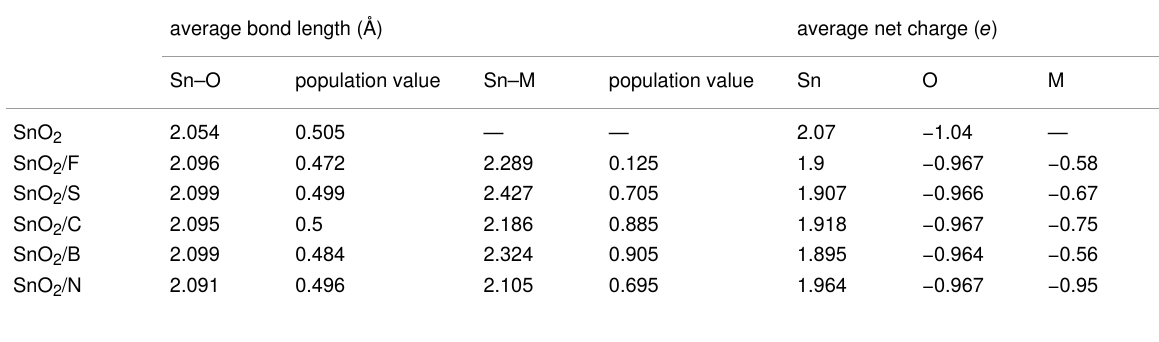
Table 2: Bond length and charge of the crystal structure with a non-metal atom replacing an O